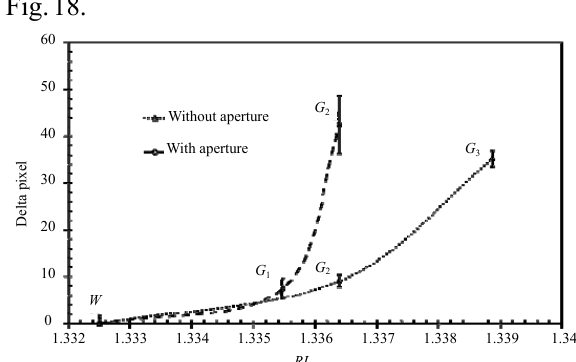
Fig. 18 Response of Channel 1, with and without aperture, following the second approach of image